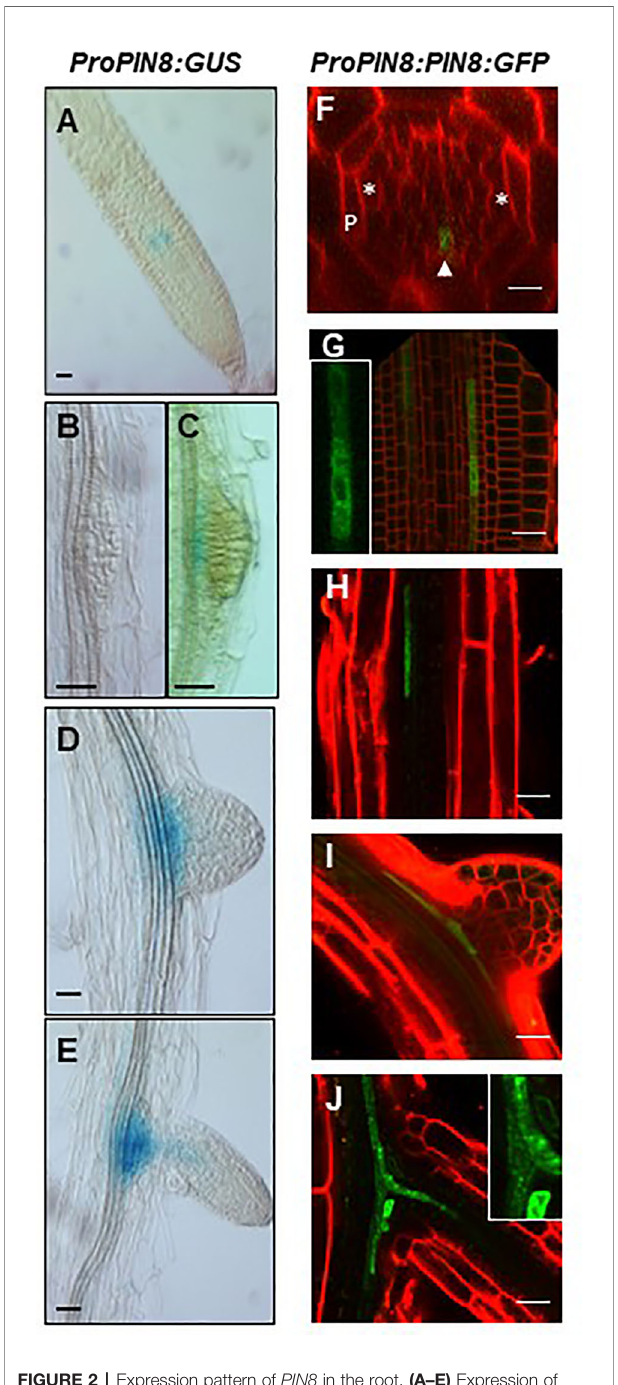
FIGURE 2 | Expression pattern of PIN8 in the root. (A – E) Expression of ProPIN8:GUS in the root meristem region (A) and around the developing lateral root (LR) primordia (B – E) . (F – J) Expression of ProPIN8:PIN8:GFP in the root meristem (F – G) and elongation/maturation (H) regions and around the developing LR primordia (I – J) . Asterisks, “ P, ” and the arrowhead in F (a confocal z-section image of the root basal meristem region) indicate xylem- pole positions, pericycle, and PIN8:GFP signal, respectively. The insets of ( G, J ) are the enlarged images of PIN8:GFP -expressing cells. Red signals represent FM4-64 staining. Scale bars = 20